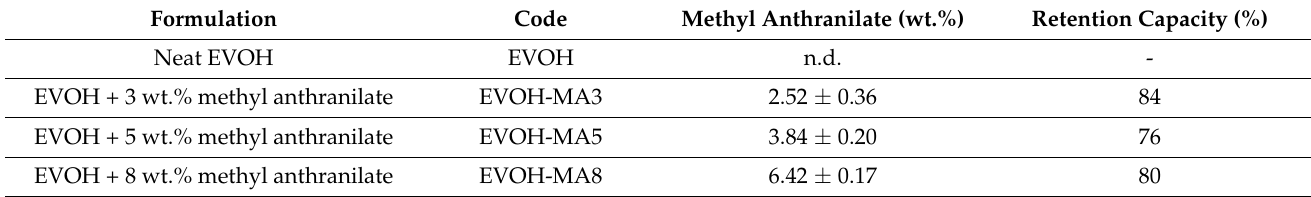
Table 1. Film formulations and retention capacity of methyl anthranilate quantified by GC-MS analysis.